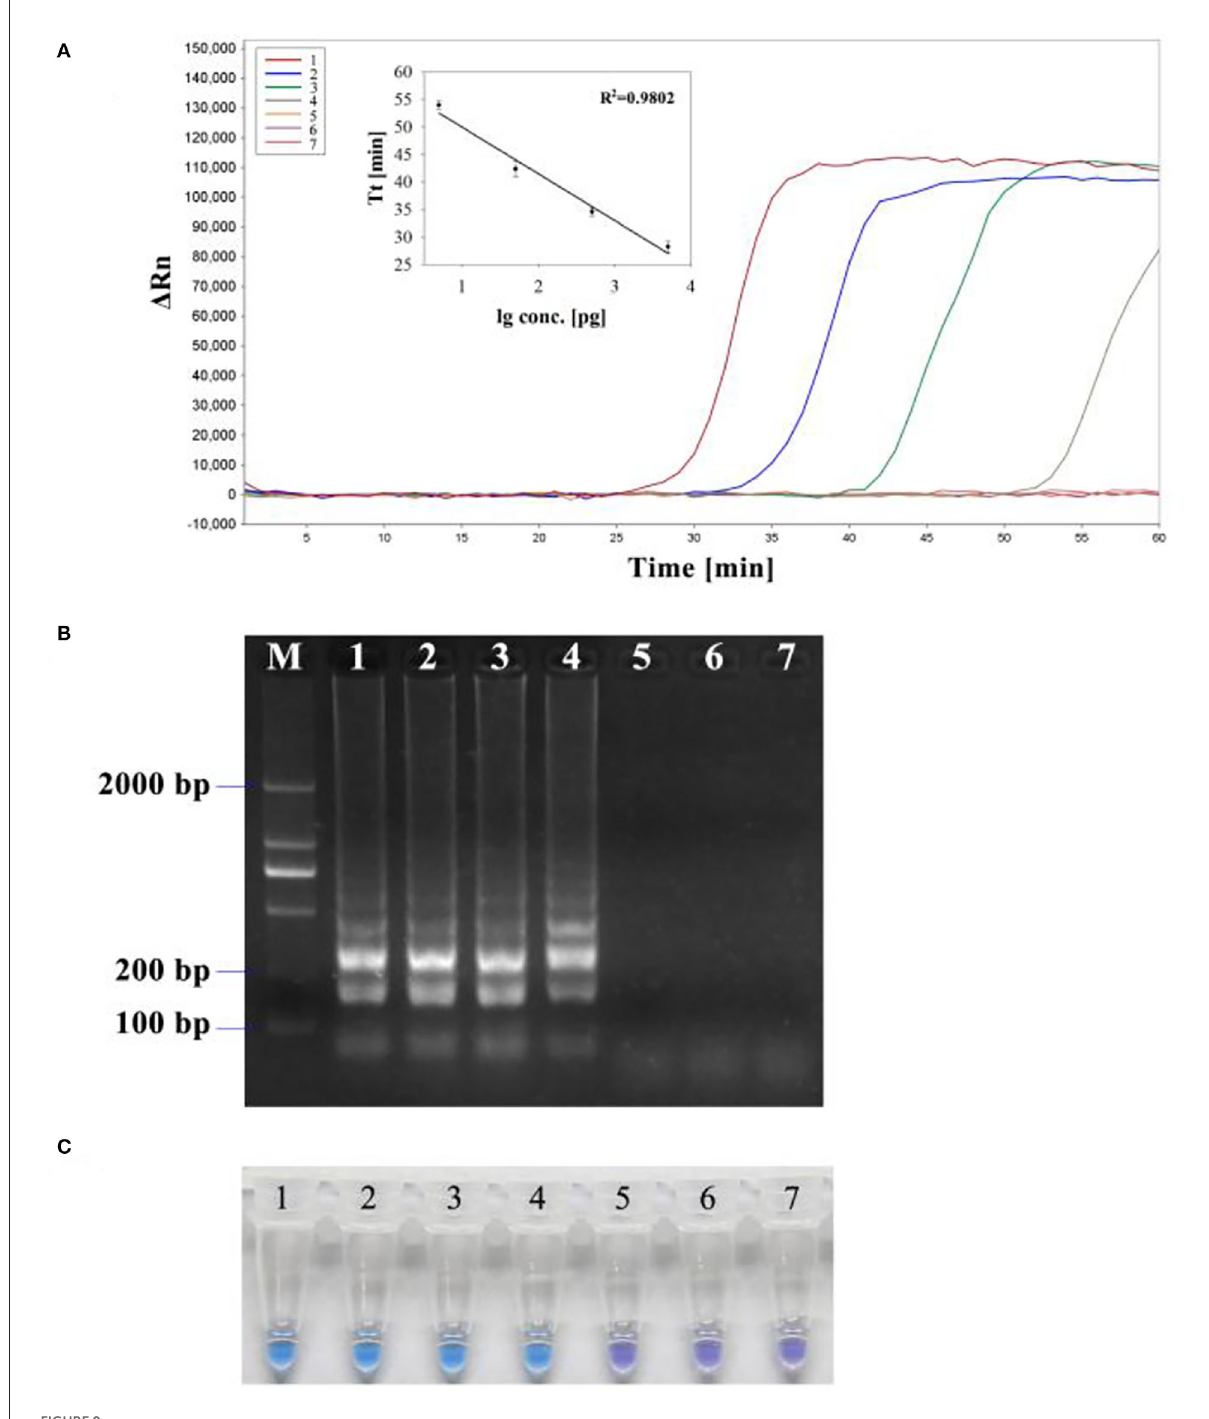
FIGURE9 Sensitivity of the LAMP assay for R. subnigricans . A dilution series of R. subnigricans DNA was prepared as follows: (1) 5 ng; (2), 500 pg; (3) 50 pg; (4) 5 pg; (5) 500 fg; (6) 50 fg; and (7) no template for negative control. (A) Real-time quantitative LAMP (RT-qLAMP) analysis with different DNA concentrations. The standard curve based on this dilution series showed a linear relationship between the log of the quantity of initial template DNA (lg conc.) and threshold time ( Tt ). The coefficient of determination ( R 2 ) of the linear regression was 0.9802. (B) Electrophoresis-LAMP with different DNA concentrations. (C) HNB-LAMP with different DNA